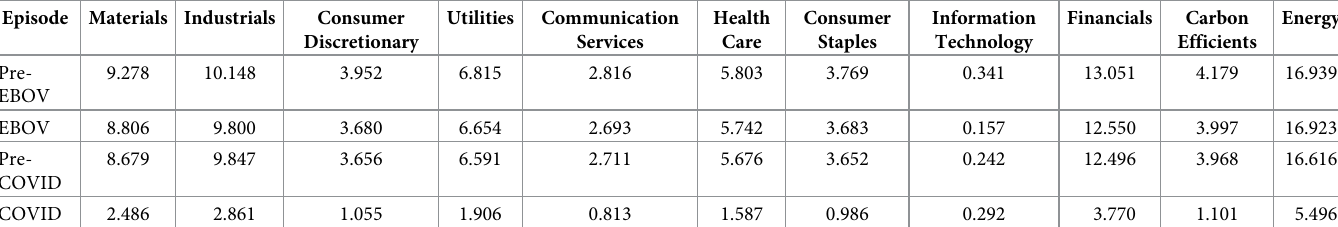
Table 10. Optimal weights of sectoral indices in the IEMV-sectoral index diversified portfolios.